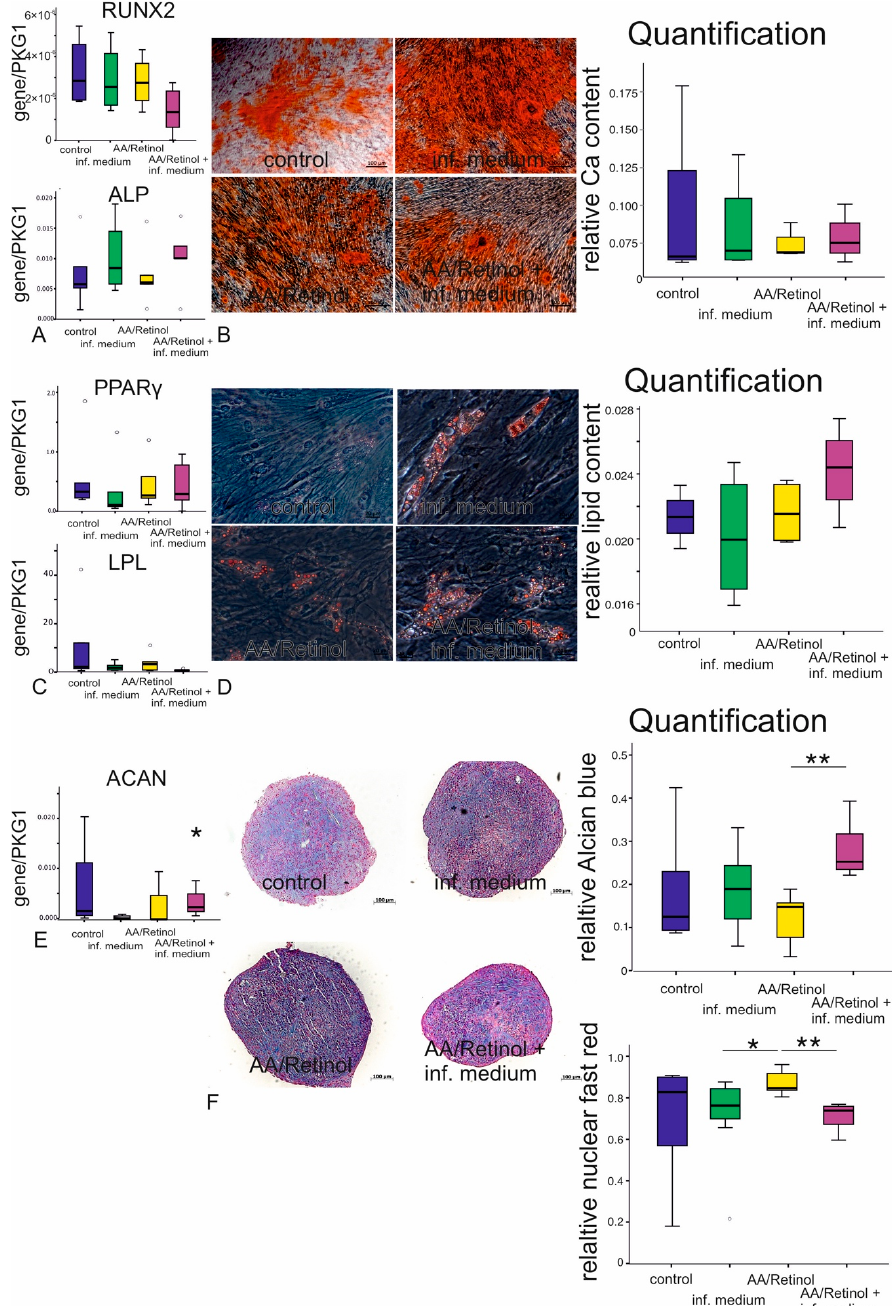
Figure 5. G-MSCs multilineage differentiation following stimulation by AA/retinol and inflammation: Gene expressions of ALP and RUNX2 following a 14-day osteogenic stimulation (( A ); box and whisker plots with medians/quartiles). Ca 2+ quan- tification and Alizarin-Red staining following a 14-day osteogenic induction of ascorbic acid and inflammation stimulated G-MSCs (( B ); box and whisker plots with medians/quartiles). LPL and PPAR γ gene expression after 21 days of adipogenic stimulation of ascorbic acid and inflammation challenged G-MSCs (( C ); box and whisker plots with medians/quartiles). Oil-Red-O staining and lipid amount quantification of ascorbic acid and inflammation stimulated G-MSCs after 21 days of adipogenic stimulation (( D ); box and whisker plots with medians/quartiles). ACAN gene expression following a 35-day chondrogenic induction of ascorbic acid and inflammation stimulated G-MSCs (( E ); box and whisker plots with medians/quartiles). Alcian-blue/nuclear-fast-red staining of ascorbic acid and inflammation stimulated G-MSCs following a 35-day chondrogenic induction ( F ) ( n = 5, a circle represents an outlier, * p < 0.05, ** p < 0.01; Friedman